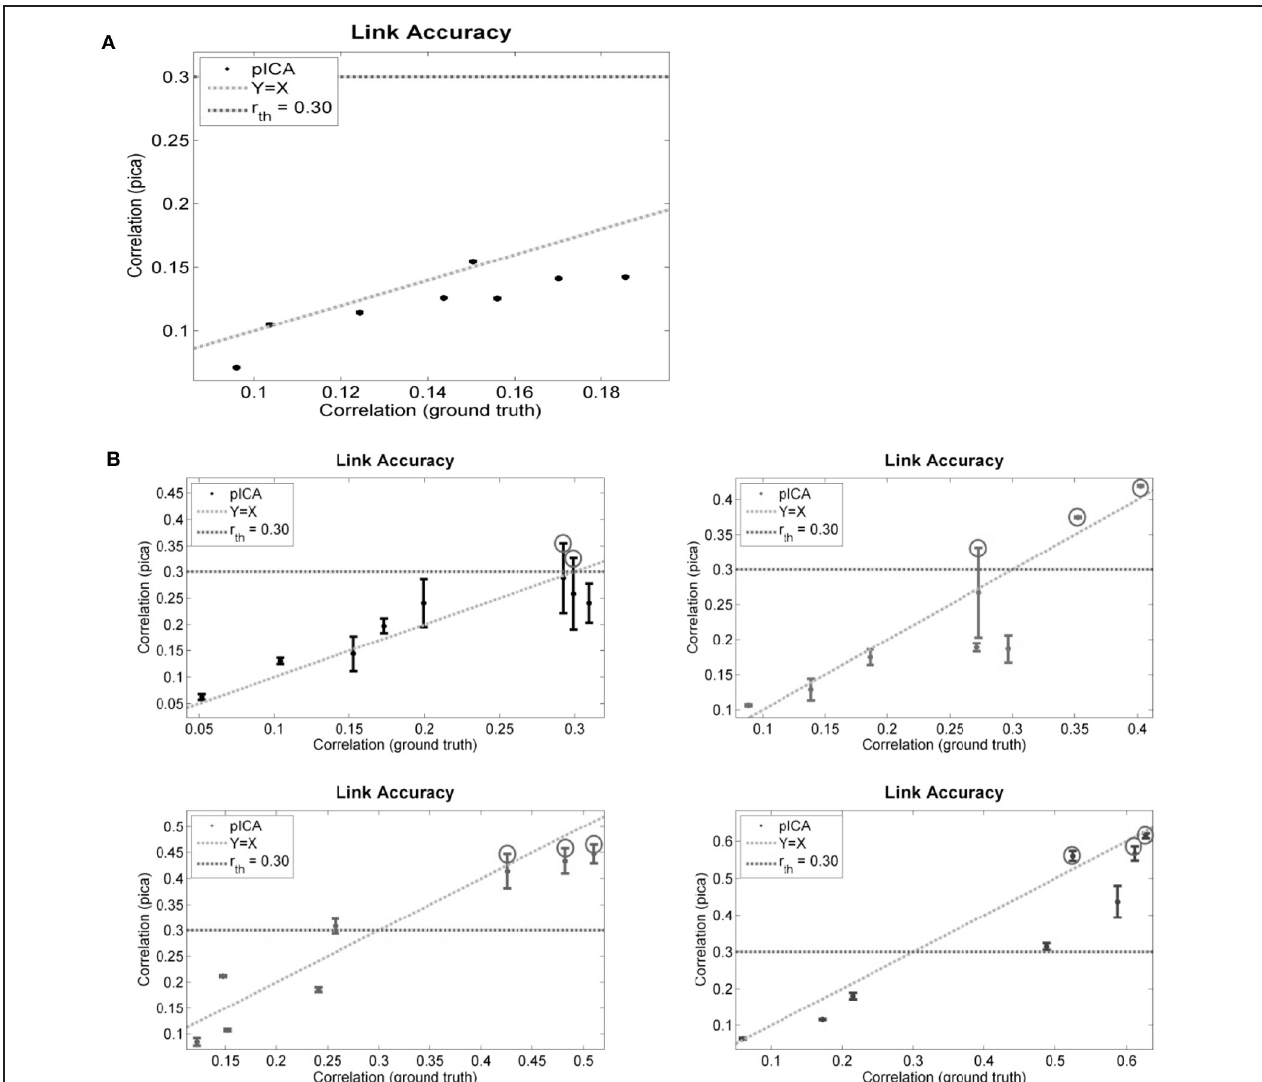
data-modalities with only sub-threshold correlations as having no inter-modal relationship (as seen in A ). When the correlation between pairs of components exceeds r_th, these components are updated in the para-ICA algorithm (as circled in B ). A maximum of three sub-threshold pairs can be updated in the para-ICA framework. Error bars represent standard deviation based on 100 iterations. Note that error bars of (A) overlap with the data points and are hard to see due to low standard